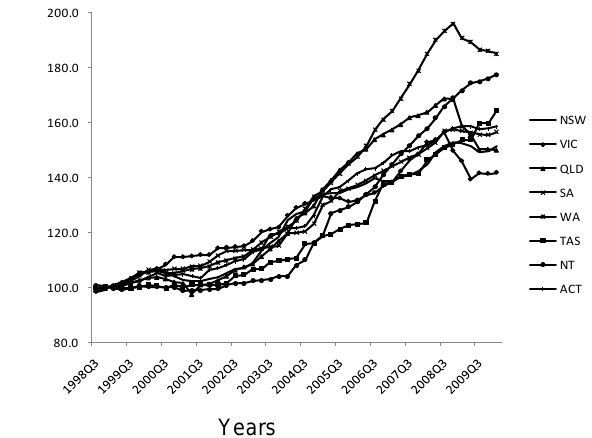
Figure 2: The output PPI of other-residential building construction in Australia